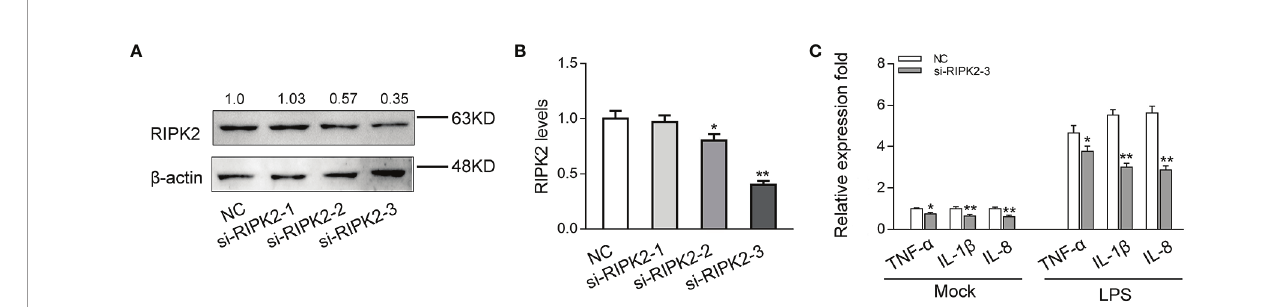
FIGURE 6 | Knockdown of RIPK2 inhibits in fl ammatory responses. (A, B) Relative mRNA and protein levels of RIPK2 in MIC cells. si-RIPK2-1, si-RIPK2-2, si- RIPK2-3 or siRNA-control mimics (NC) by western blotting (A) and qPCR assays (B) , respectively. (C) At 48 h after transfected with NC or si-RIPK2-3, MIC cells were stimulated with LPS for 6 h. The mRNA expression levels for TNF- a , IL-1 b , and IL-8 were determined and normalized to b -actin. All data are presented as the means ± SE from three independent triplicate experiments. **p < 0.01; *p < 0.05 versus the controls.